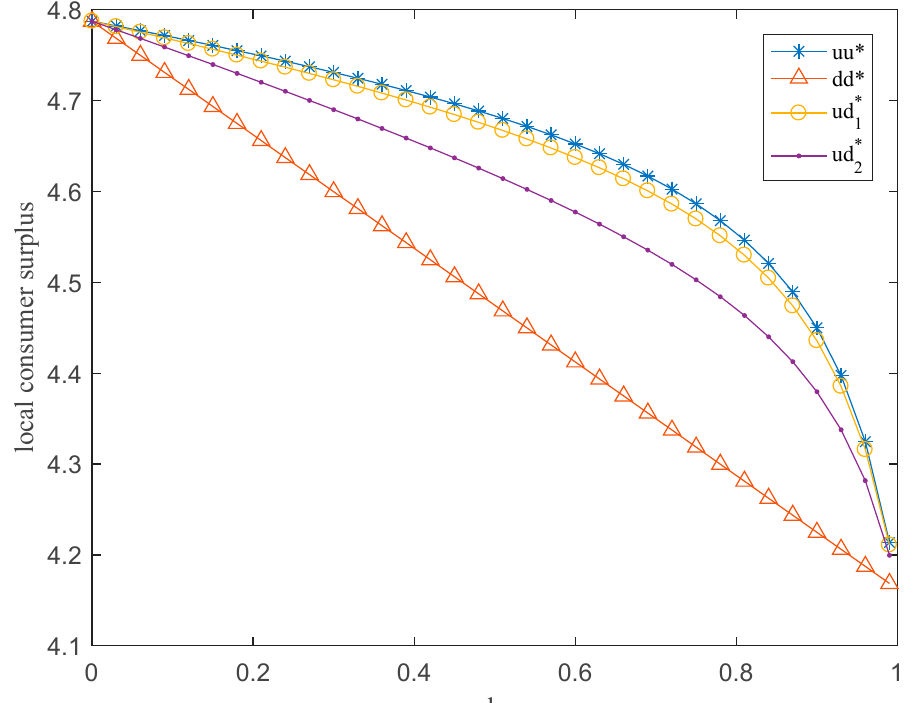
Figure 5. The local consumer surplus under different situations.